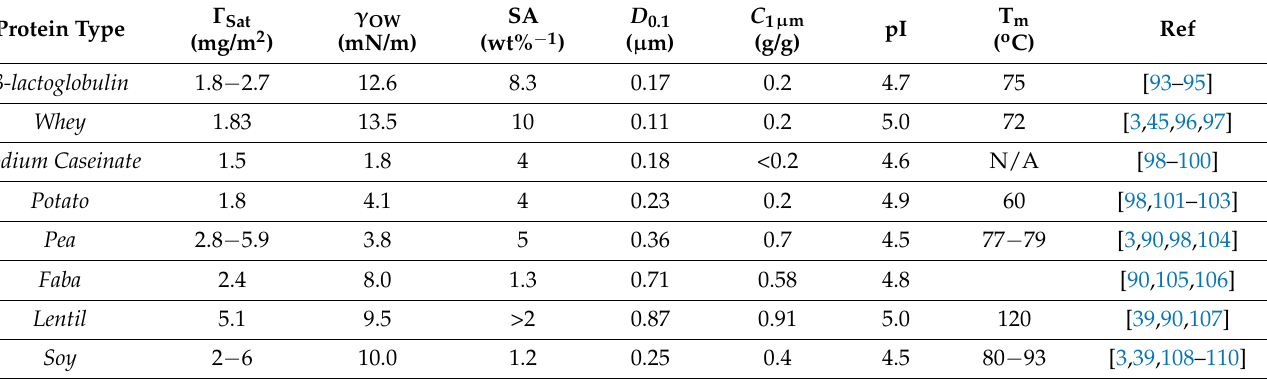
Table 1. Emulsion forming properties of food proteins. Key: Γ Sat = Surface load at saturation; γ OW